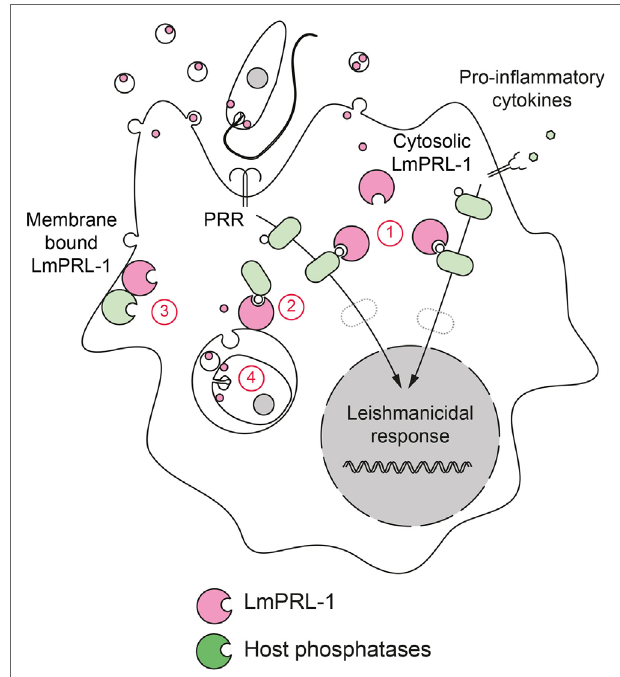
FigURe 5 | Hypotheses on the virulence mechanism of LmPRL-1. The phosphatase LmPRL-1 is secreted by Leishmania major promastigotes and amastigotes during macrophages infection. Once secreted, LmPRL-1 is localized at the membrane of the parasitophorous vacuole (PV) and/or in the cytosol of the infected macrophage. The observed support of intracellular parasite survival by LmPRL-1 could result from an inhibitory effect on important signaling pathways that otherwise promote the microbicidal response of the host macrophage (1). Other pathways not directly related to the innate immune response, but contributing to the general fitness of the macrophage and its function as host cell niche for the parasite could also be targeted by LmPRL-1 (2). Putative targets of LmPRL-1 are the host PRL proteins. Mammalian PRL activity relies on the formation of PRL trimers. LmPRL-1 might modulate the activity and function of its mammalian orthologs by physically interacting with them (3). Finally, a parasite- autonomous, intrinsic prosurvival effect of LmPRL-1 also needs to be envisaged